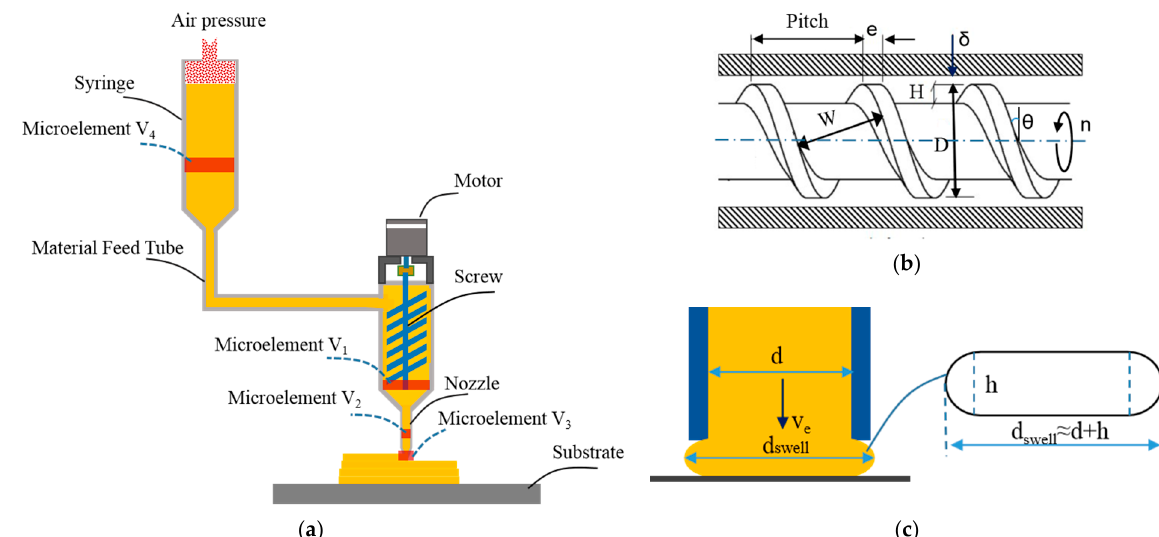
Figure 1. Schematic of extrusion-based three-dimensional printing of ceramic paste: ( a ) static differential model of the extrusion process, ( b ) geometric parameters of auger, and ( c ) the desirable shape of an extrudate.